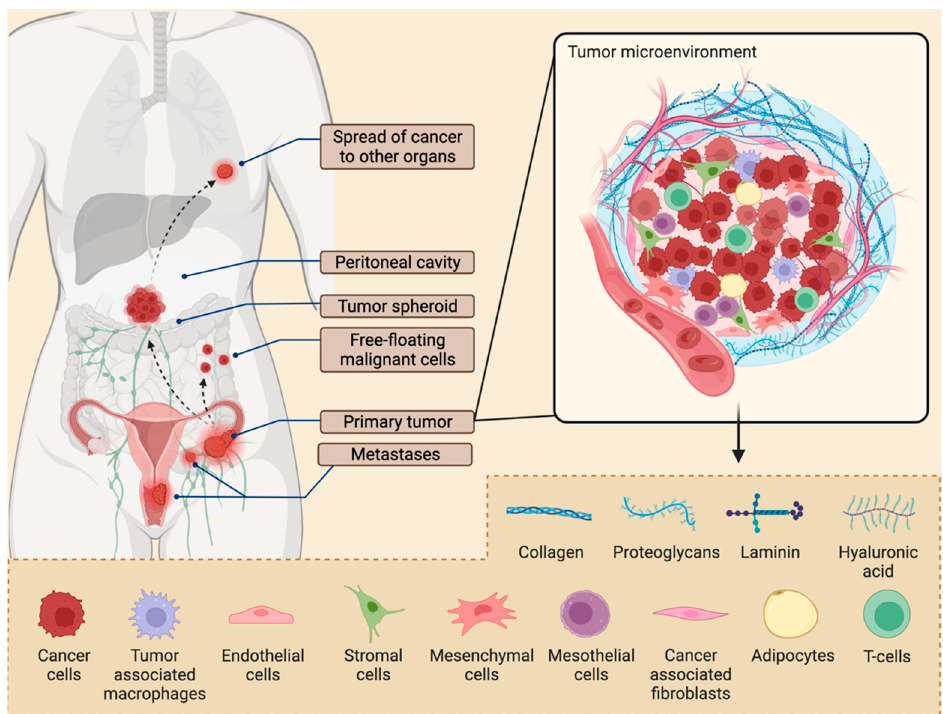
Figure 1. Ovarian cancer metastasis and tumor architecture. Created with BioRender.com. Macrophages contribute to a tumor-friendly environment that induces angiogenesis, supports metastatic growth on the omentum, and supports chemoresistance [28–30]. In solid tumors, these effects are further enhanced by neighboring adipocytes, which attract cancer cells through IL-8 and further boost proliferation through the secretion of fatty ac- ids [31]. Tumor-associated macrophages (TAMs) consist of the M-1 type with anti-tumor activities, and the M-2 type with pro-tumor activities. The latter is stimulated by IL-4, -10, and -13 secreted from tumor cells [32]. M-2 macrophages are a major component in ovar- ian cancer known to suppress T-cell proliferation and boost immune suppression via T reg cell activation [33]. These cells express CTLA-4 and PD-1 receptors, therefore inhibiting cytotoxic functions [34]. M2 cells are further involved in tissue repair, ECM remodeling, and angiogenesis. Another immunosuppressive cell population, myeloid-derived sup- pressor cells (MDSCs), act in synergy with M2 TAMs to block natural killer cells and cy- totoxic T-cells, resulting in cancer cell immune escape [30,35–37].